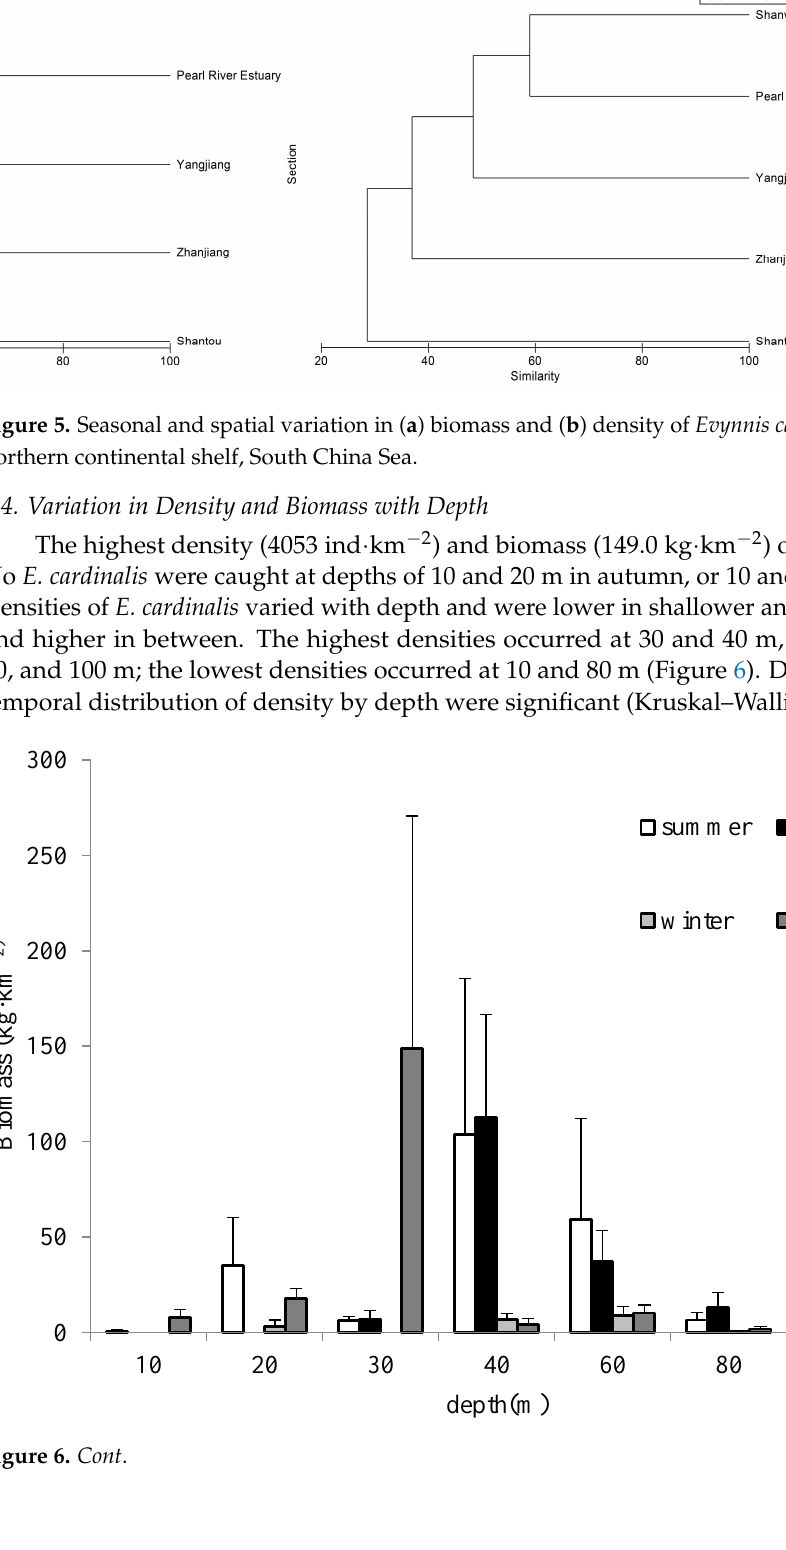
Figure 5. Seasonal and spatial variation in ( a ) biomass and ( b ) density of Evynnis cardinalis across the northern continental shelf, South China Sea.